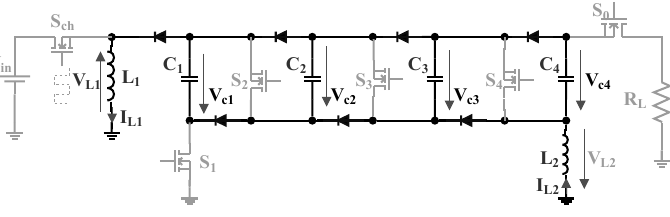
Figure 4. Phase 1 (B): energy transfer to the capacitors.